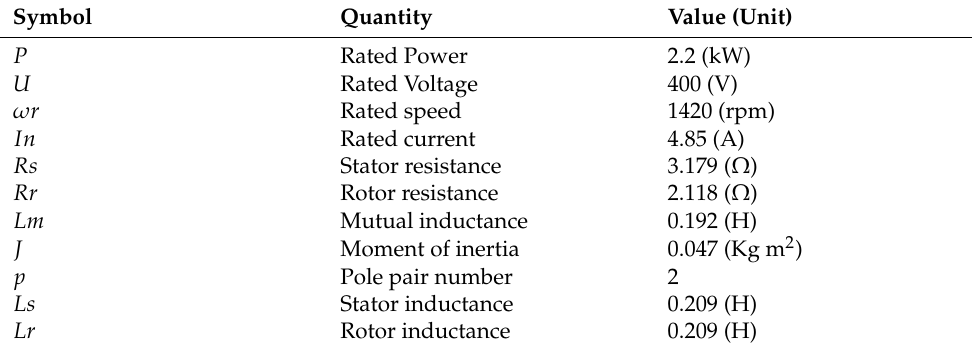
Table 2. Induction motor